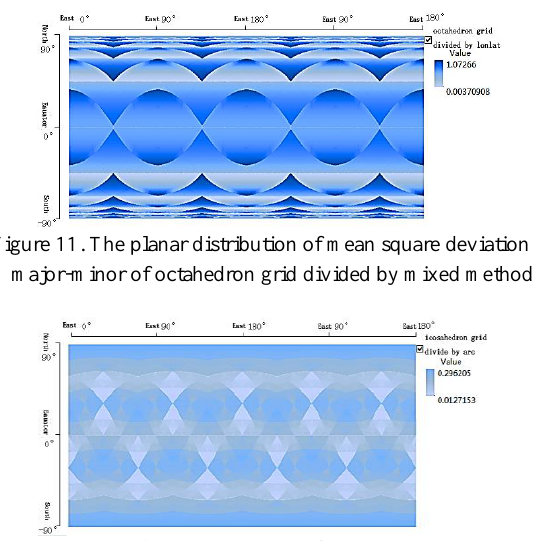
Figure 16. The planar distribution of mean square deviation of